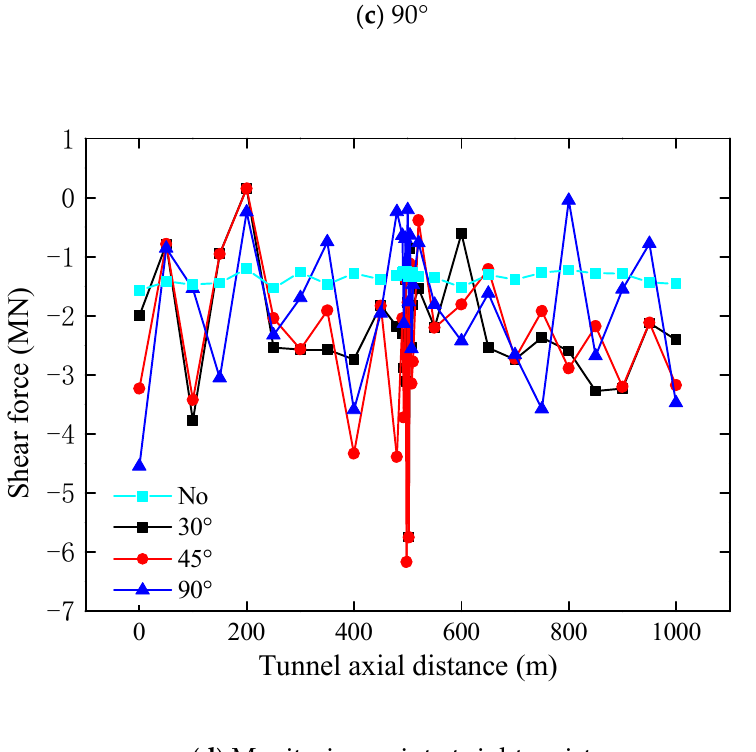
Figure 11. Shear force of the lining monitoring points of the tunnel passing through adverse geological structure zone with different inclinations along the tunnel axial direction.